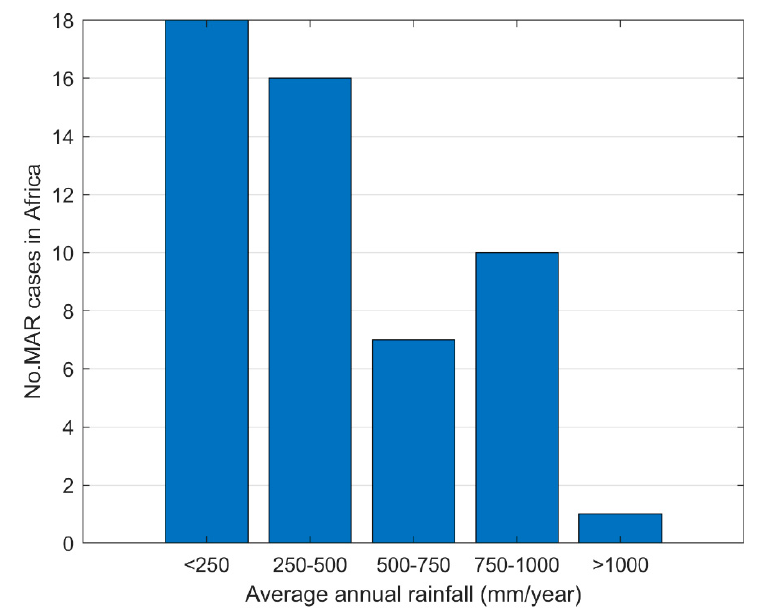
Figure 7. Number of MAR cases in Africa per average annual rainfall class (n = 52).